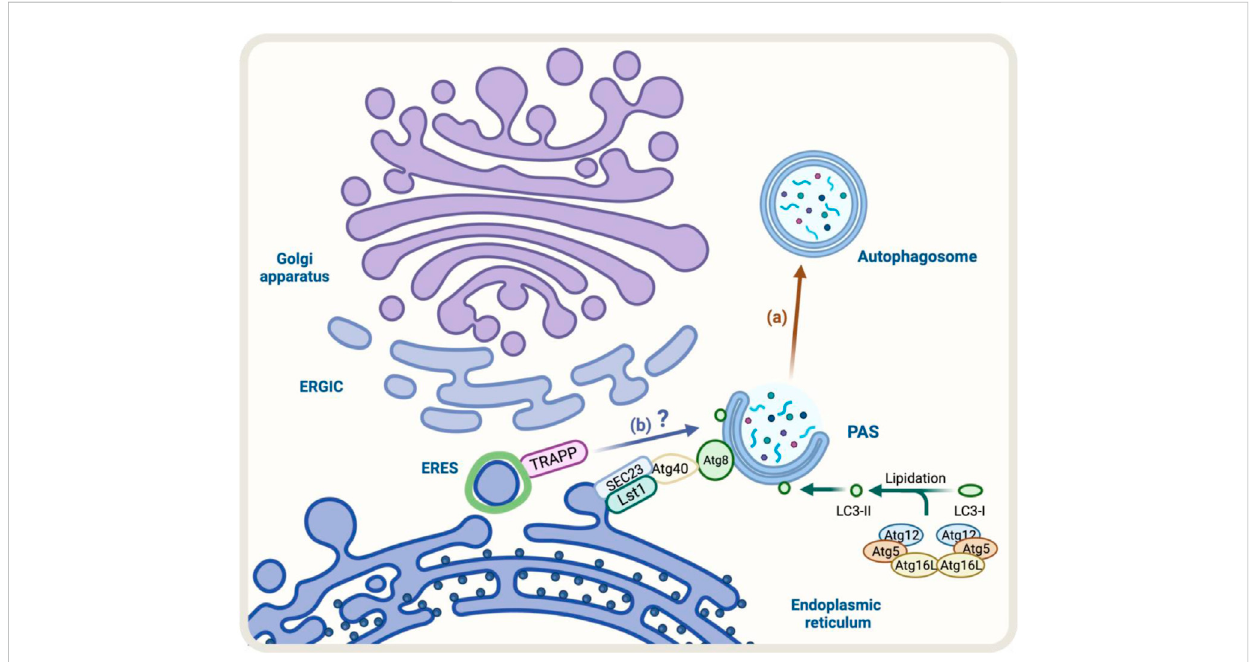
FIGURE 4 Diagramrepresentationoftheregulatorsofautophagyandearlyconventionalsecretorypathwayunderstress. (A) DuringER-phagy,componentsof COPII complex suchas Lst1/SEC24C-SEC23 caninteractwith Atg40, aspeci fi cER-phagy receptor,whichbindsto Atg8/LC3 allowingthedegradationof theERbyautophagy(brownarrow) (B) TRAPPcomponentsrespondtoGolgistresswithimpactonautophagy,however,themolecularmechanismisnot fully resolved (blue